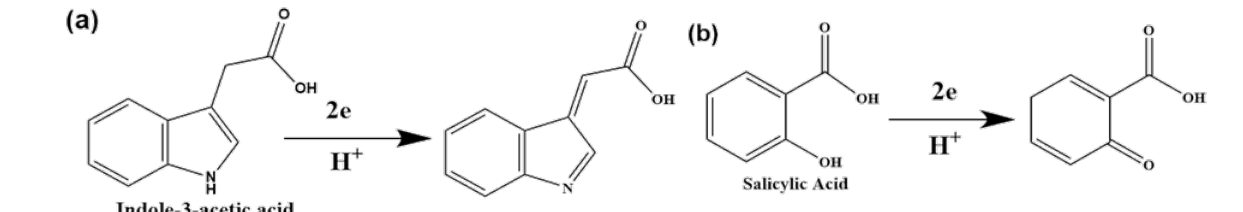
Figure 7. ( a ) LSV curves of PPRONPs − CDs − MWCNTs/GCE in PBS containing 50 μM IAA and 50 μM SA at different pH values. Scan rate is 100 mV/s. ( b ) The linear correlation of E p of IAA vs. Ph. ( c ) The linear correlation of E p of SA vs. pH.